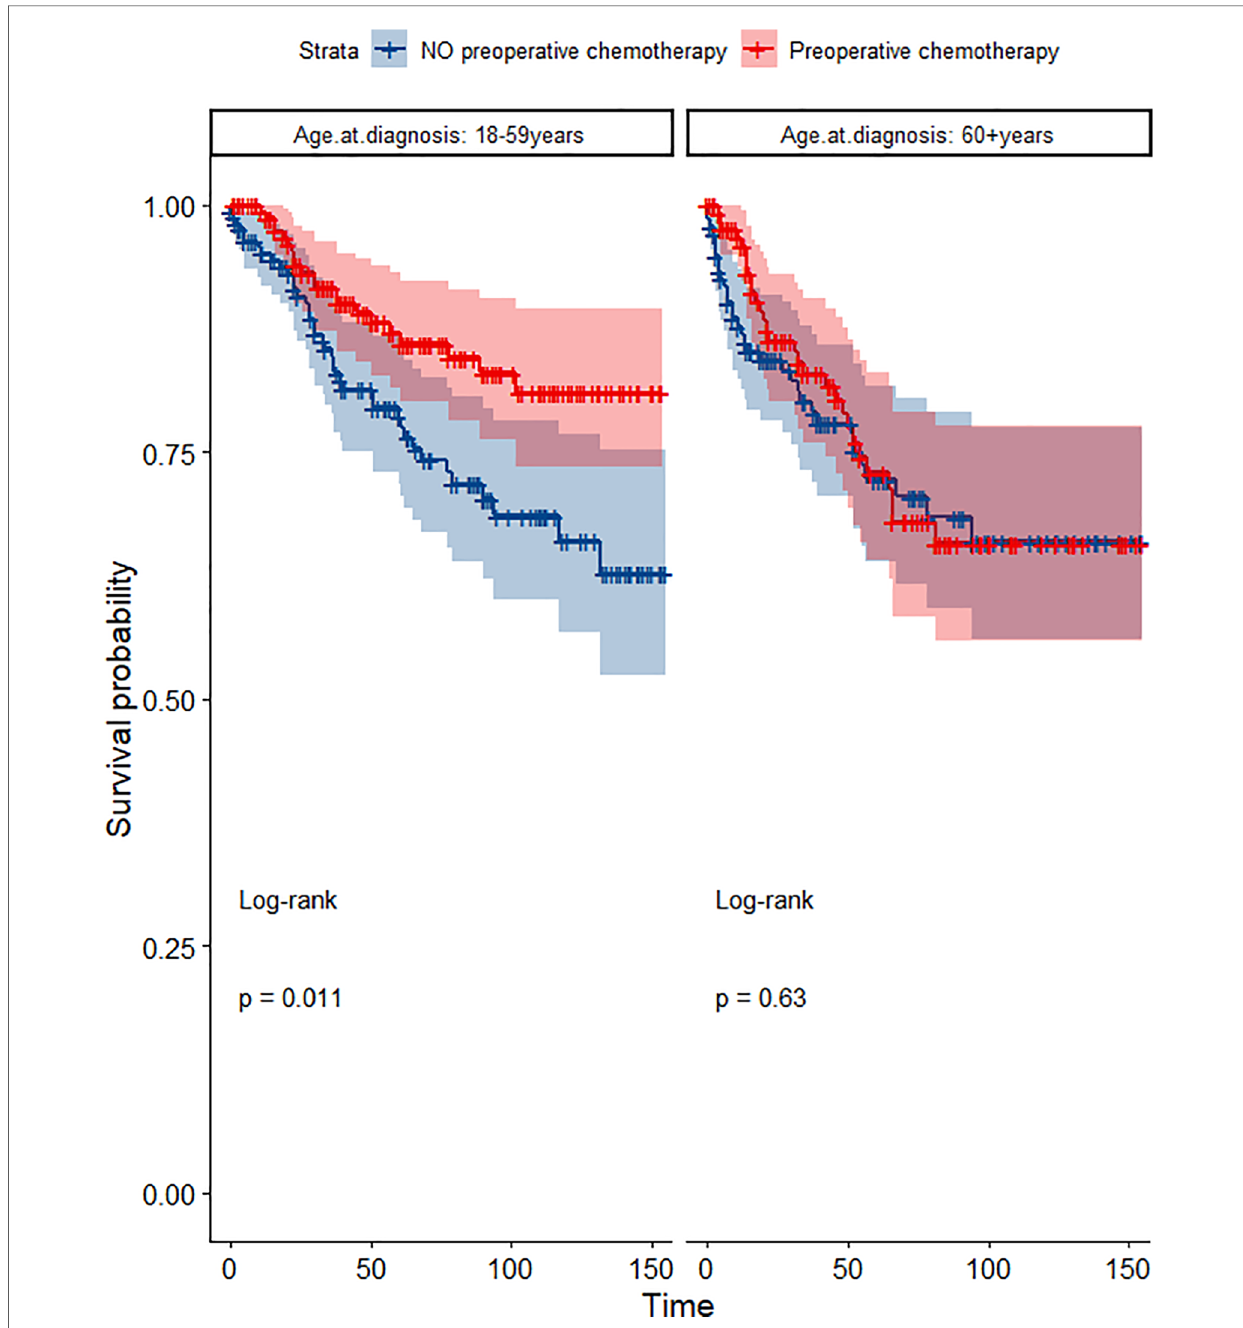
FIGURE 10 Survival curves of CSS in the POCT and no POCT groups in patients undergoing surgery for TETs in different age groups after propensity